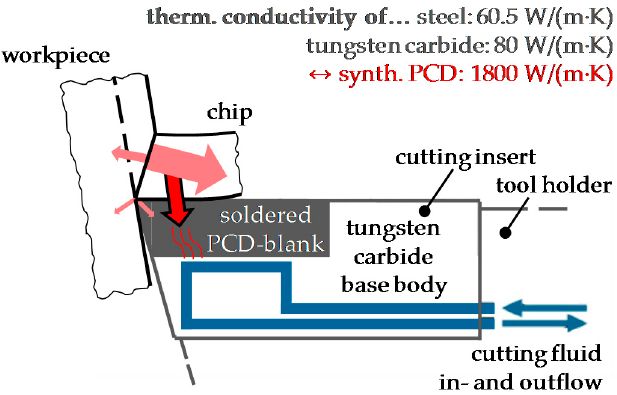
Figure 1. Schematic illustration of cutting process with internally cooled PCD cutting insert and indicated transmission of resulting process heat (red arrows).